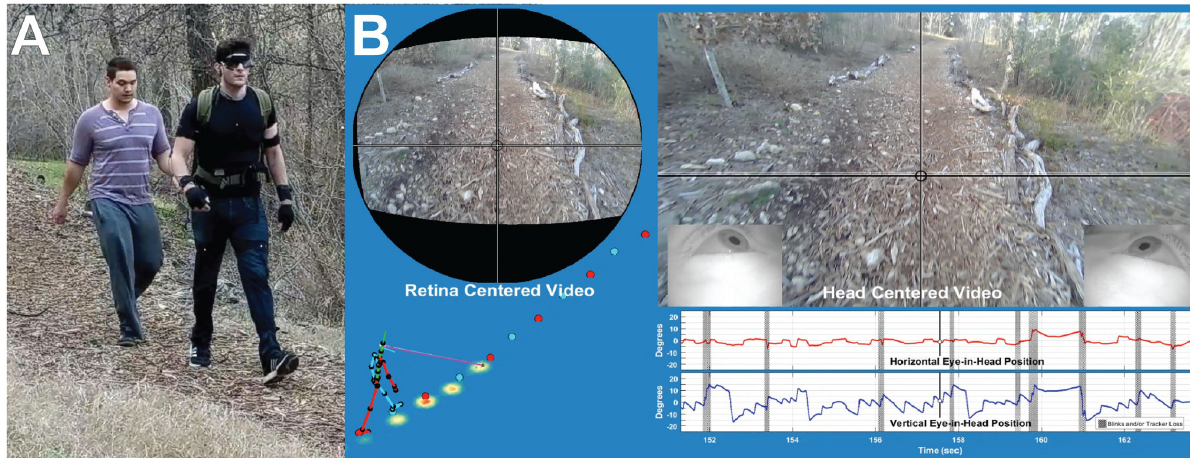
Fig 1. The data collection setup. (A) shows the subject walking in the Woodchips terrain wearing the Pupil Labs binocular eye tracker and Motion Shadow motion capture system. Optometrist roll-up sunglasses were used to shade the eyes to improve eye tracker performance. (B) shows a sample of the data record, presented as a sample frame for S1 Video. On the right is the view of the scene from the head camera, with gaze location indicated by the crosshair. Below that are the horizontal and vertical eye-in-head records, with blinks/tracker losses denoted by vertical gray bars. The high velocity regions (steep upwards slope) show the saccades to the next fixation point, and the lower velocity segments (shallow downwards slope) show the component that stabilizes gaze on a particular location in the scene as the subject moves towards it, resulting a characteristic saw-tooth appearance for the eye signal (without self-motion and the associated stabilizing mechanisms these saccades would exhibit a more square-wave like structure). On the left, the stick figure shows the skeleton figure reconstructed form the Motion Shadow data. This is integrated with the eye signal which is shown by the blue and pink lines. The representation of binocular gaze here shows the gaze vector from each eye converging on a single point (the mean of the two eyes). The original ground intersection of the right and left eye is shown as a magenta or cyan dot (respectively, more easily visible in S1 Video). The blue and red dots show the foot plants recorded by the motion capture system. The top left figure shows the scene image centered on the point of gaze reconstructed from the head camera as described in the Methods and Materials section.